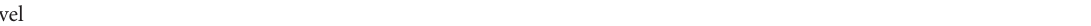
Table 1: AACN’s new evidence-leveling